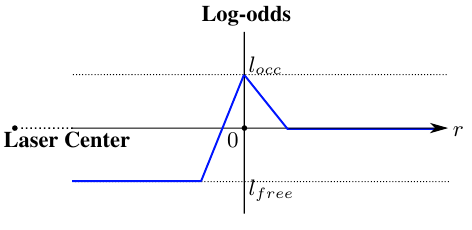
Figure 6. Log-odds in ray